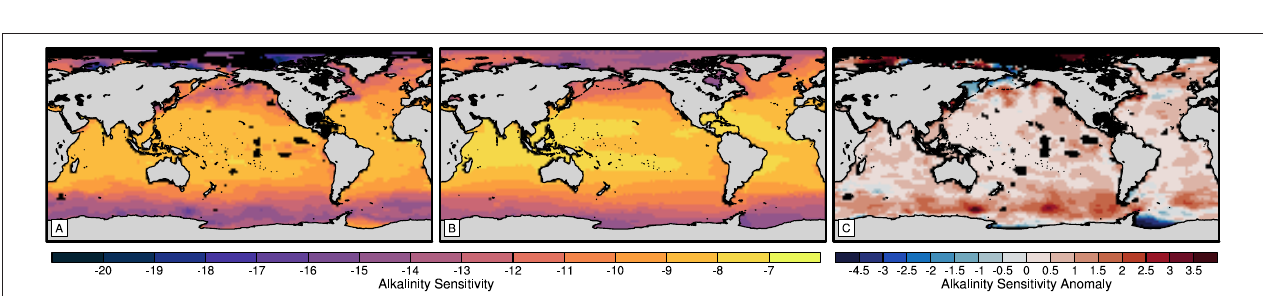
FIGURE 3 | Maps of alkalinity sensitivity derived from the (A) GLODAPv2 climatology surface vertical-mean and (B) 75-year mean surface model control state and (C) alkalinity sensitivity anomalies between the alkalinity sensitivities derived from the model control and GLODAPv2